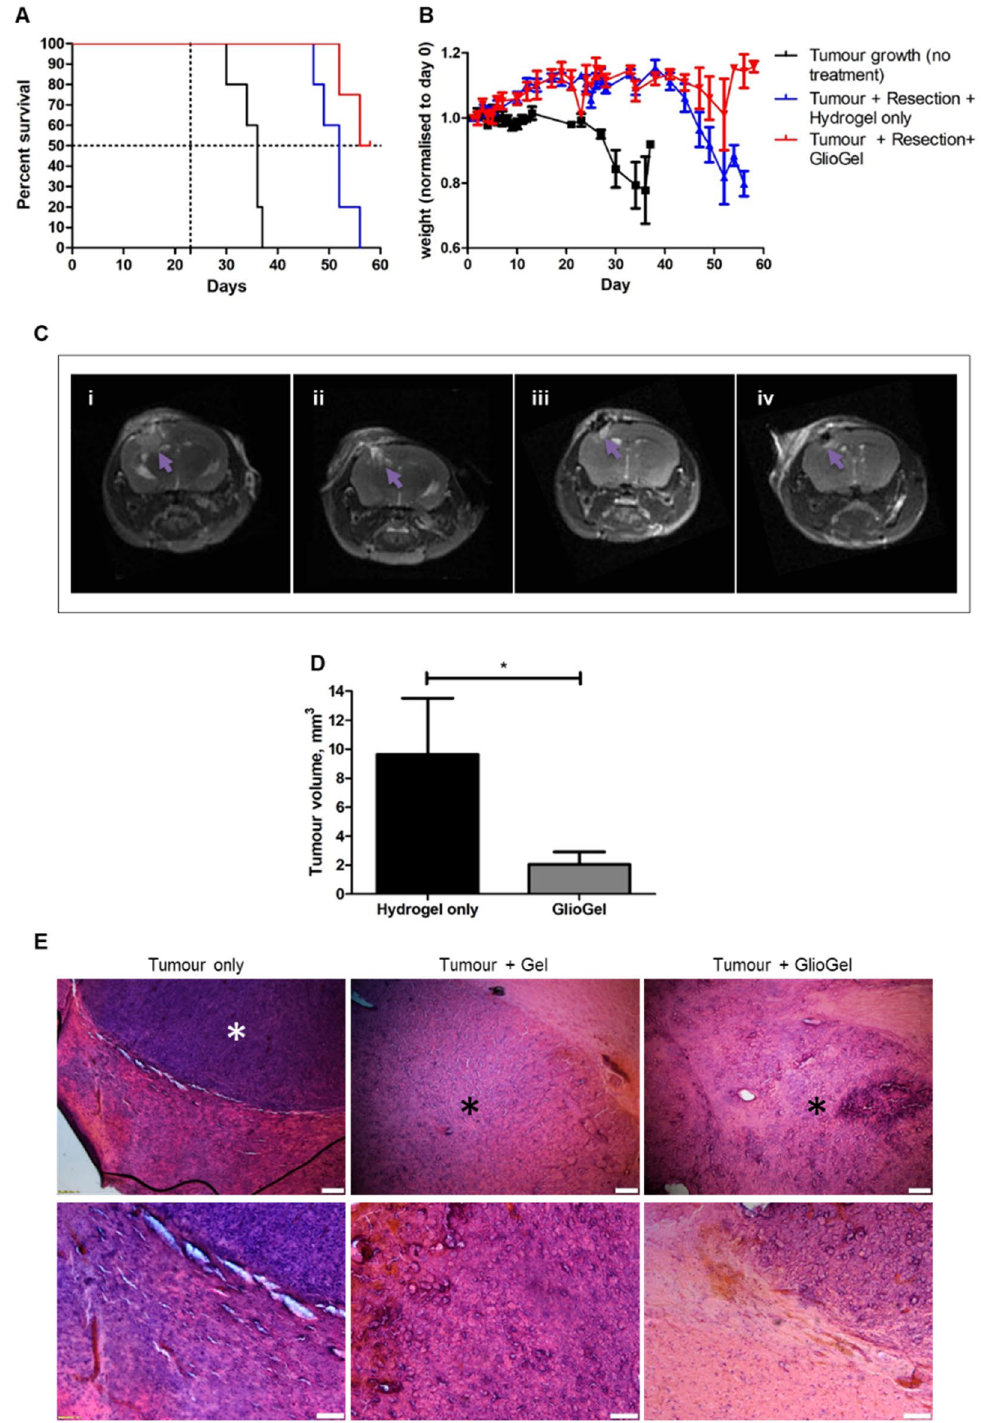
Figure 13. GlioGel anti-tumour effect in vivo. ( A ) Kaplan–Meier survival curves of U-87 tumour-bearing mice. Dotted lines indicate 50% survival and the day of resection surgery (day 23). Statistically significant differences were found between untreated and treatment groups: “Resection + Hydrogel only” (p = 0.0021) and “Resection + GlioGel” (p = 0.0098). ( B ) Mice weight change over time. From day 47 there are statistically significant differences between the groups “Resection + Hydrogel only” and “Resection + GlioGel” (day 47—p < 0.05; day 49 and day 54—p < 0.01; day 52 and 56—p < 0.001). ( C ) MRI of tumour regrowth one week after resection: (i) Resection + Hydrogel only. (ii) Resection + GlioGel treatment. (iii and iv) Tumour + GlioGel treatment long-term survivors. The arrow indicates the area of tumour regrowth (bright areas correspond to the tumour in T1 weighted images. In (iv), the dark area in the brain corresponds to the surgical cavity). ( D ) Tumour volume comparison one week after resection. Statistical test: non-parametric Mann– Whitney test (*p < 0.05). (Tumour growth + resection + hydrogel only, n = 5; Tumour growth + resection + GlioGel, n = 4). ( E ) Histology analysis of brain tissue. Notice haematoxylin rich tumour area which is denser in the tumour only group (control group—without resection surgery and without treatment). White * indicates dense tumour areas and black * indicates less dense tumour areas. Upper panels scale bar 200 μm; lower panels scale bar 100